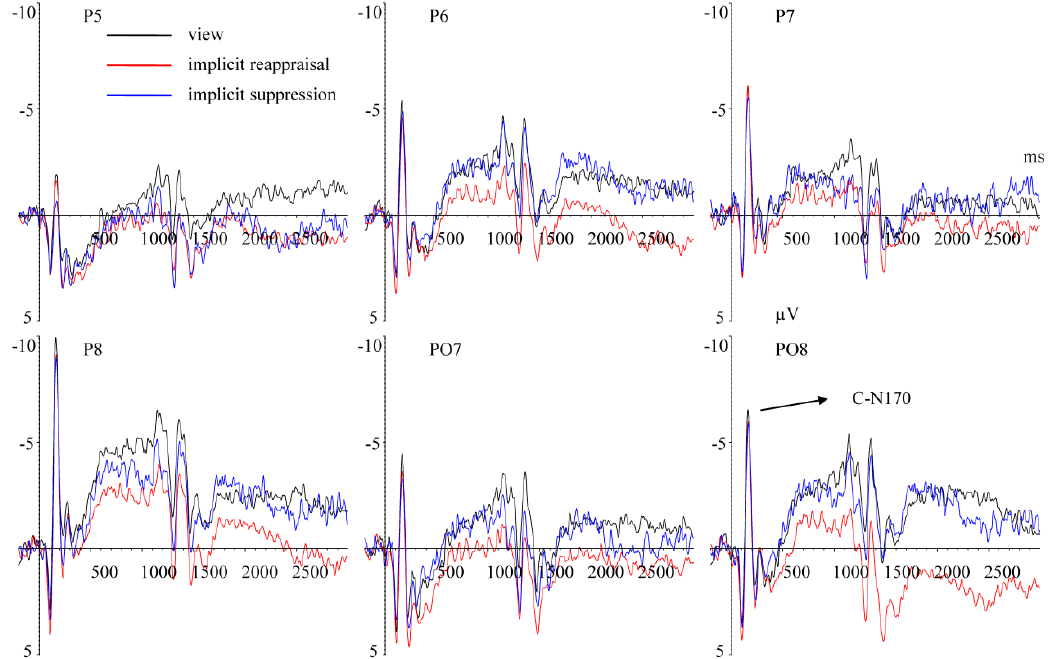
Figure 3. Grand average ERPs of C–N170 components elicited by completing the MCE task under view (black lines), implicit reappraisal (red lines), and implicit suppression (blue lines) conditions recorded at P5, P6, P7, P8, PO7, and PO8.